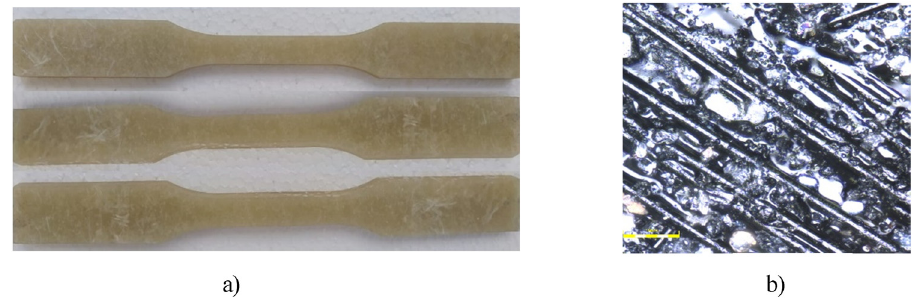
Figure 5: View of samples with 10% recyclate content ( a ) and structure of the K10 composite at magni fi cation 50 × ( b ) .